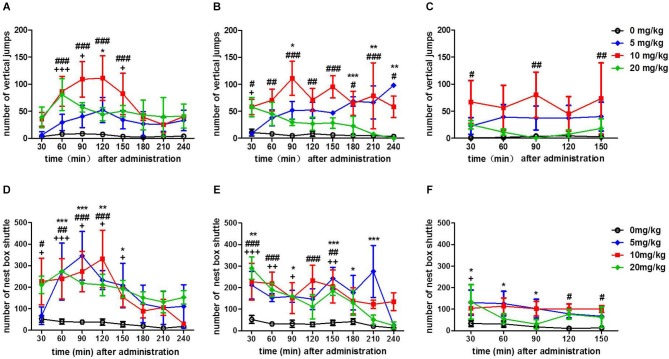
Number of vertical jumps and horizontal shuttles between the cage and nest box after the injection of different doses (0, 5, 10, 20 mg/kg, IM) of morphine, which were considered as the vertical and horizontal activity indices, respectively. The number of vertical jumps after the first time (A), the second time (4 h after the first time) (B) and the third time (4 h after the second time) (C) administration of three doses of morphine. The number of horizontal shuttles between the cage and nest box after the first time (D), the second time (4 h after the first time) (E) and the third time (4 h after the second time) (F) administration of three doses of morphine. “*”, “#” and “+” represent, respectively, the significant difference between 5, 10 or 20 mg/kg and 0 mg/kg morphine. */#/+
p < 0.05, **/##/++
p < 0.01, and ***/###/+++
p < 0.001 vs. 0 mg/kg morphine. The data are expressed as means ± SEM, and analyzed using two-way ANOVA followed by Bonferroni post hoc test, n = 3.